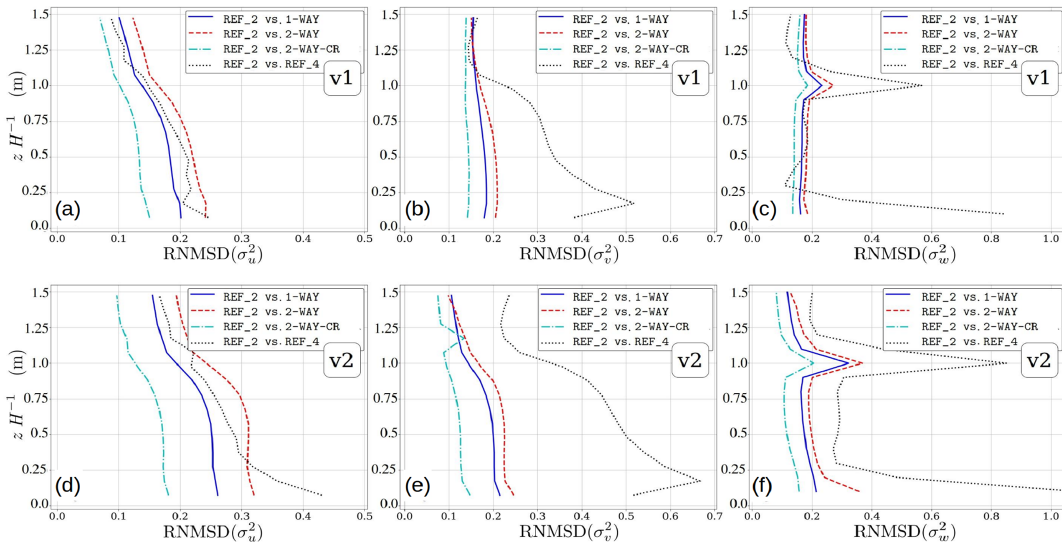
Figure 19. Vertical distribution of RNMSD of the velocity variances for configuration v1 (a–c) and configuration v2 (d–f) . The metrics are evaluated for 15 horizontal planes in the range 0 ≤ z/H ≤ 1 .